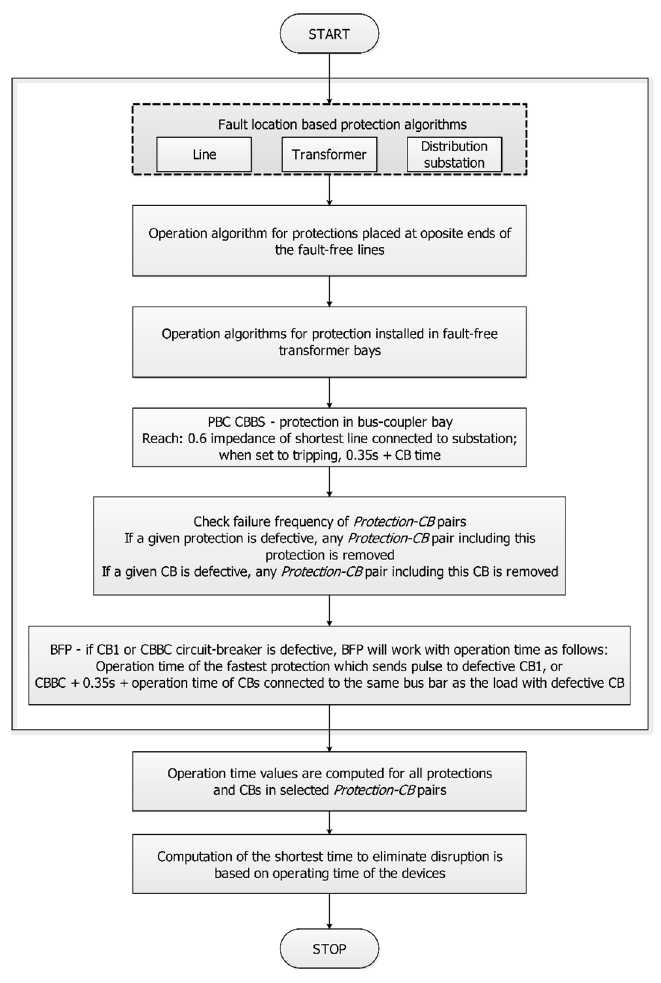
Figure 4. General algorithm for simulation-based finding of short circuit duration (Adapted with permission from [14], Piechocki, P. Frackowiak, R., Eksploatacja i Niezawodno ść - Maintenance and Reliability, Polish Maintenance Society, 2017).